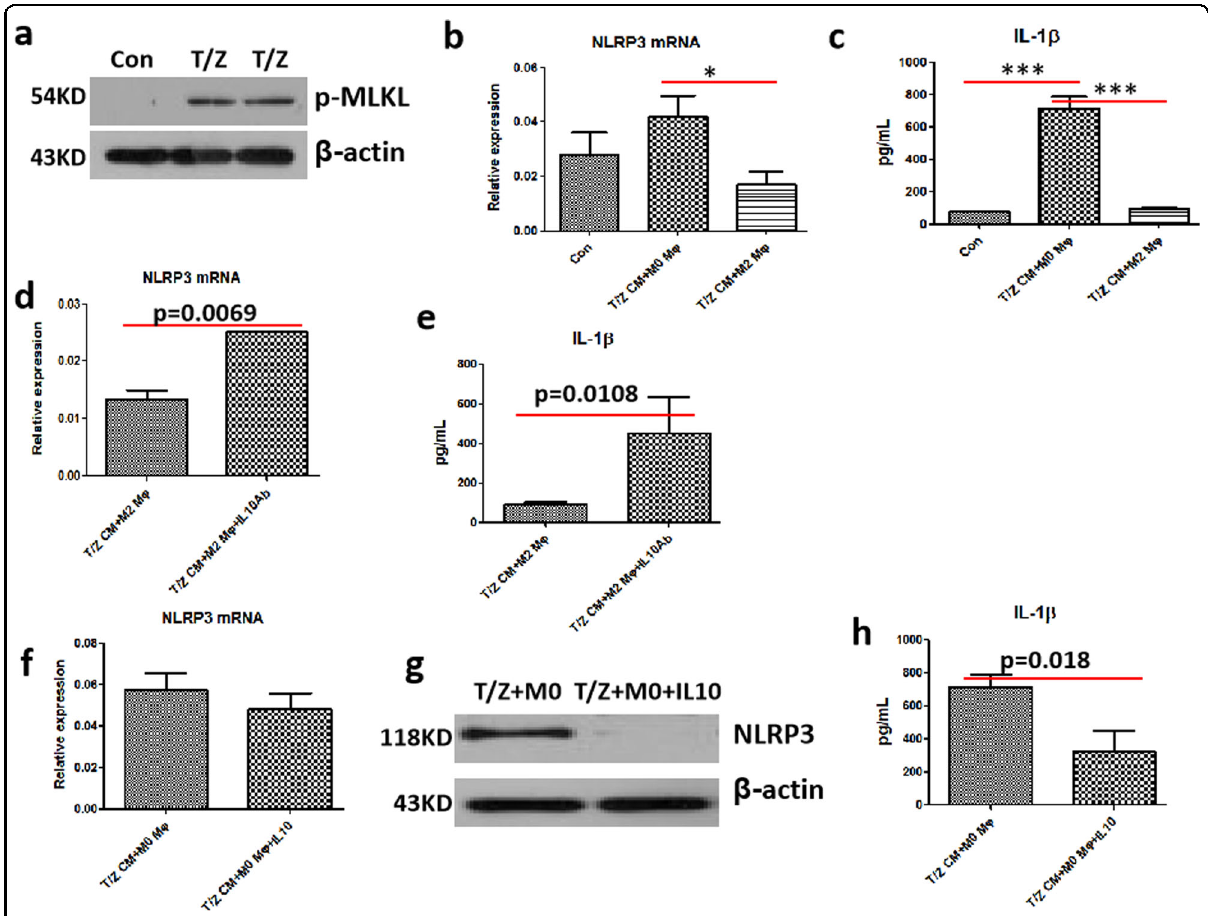
Fig. 6 M2-like macrophages inhibit necroin fl ammation via IL-10 in vitro. a Necroptosis was induced by TNF- α /z-VAD (T/Z) in AML-12 hepatocytes, and the representative marker of necroptosis, p-MLKL, was detected by western blot analysis. b , c M0 or M2 macrophages were incubated with CMs from necroptotic AML-12 cells (T/Z CM), then the mRNA levels of NLRP3 and the protein levels of IL-1 β were detected by real- time PCR ( n = 3) and ELISA assay ( n = 5 – 9), respectively. d , e M2 macrophages were incubated with CMs from necroptotic AML-12 cells (T/Z CM) and IL-10 antibody, the gene levels of NLRP3 ( n = 4) and the protein levels of IL-1 β ( n = 4 – 9) were detected by real-time PCR and ELISA, respectively. f – h M0 macrophages were incubated with CMs from necroptotic AML-12 cells (T/Z CM) and recombinant mouse IL-10 cytokine, the gene and protein levels of NLRP3 were assessed by real-time PCR ( n = 3) and western blot, respectively. The protein levels of IL-1 β were assessed by ELISA ( n = 4 –